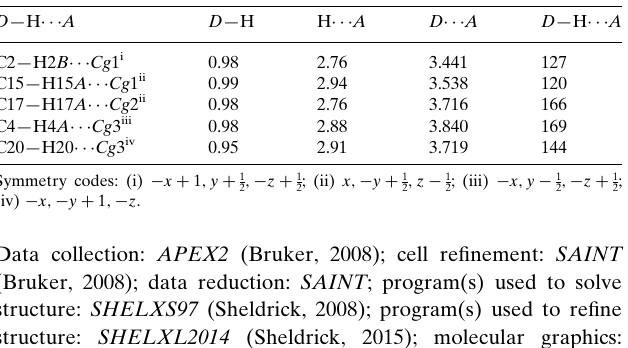
Hydrogen-bond geometry (A˚ , (cid:4) ). Cg 1, Cg 2 and Cg 3 are the centroids of the C31–C36, C43–C48 and C61–C66 aromatic rings,